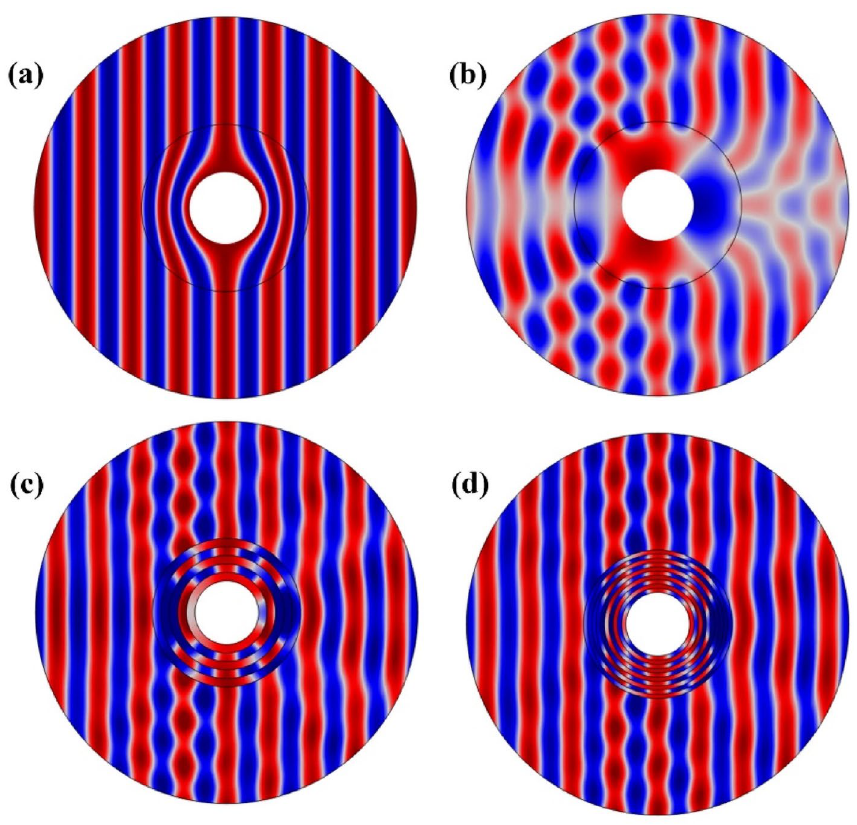
Figure 2. The total acoustic pressure field calculated by the FEM method at f = 29 kHz for ( a ) homogeneous cloak with anisotropic materials, ( b ) structure without cloak in MNE substrate, ( c ) multi-layer cloaking with 5 layers and ( d ) multi-layer cloaking with 10